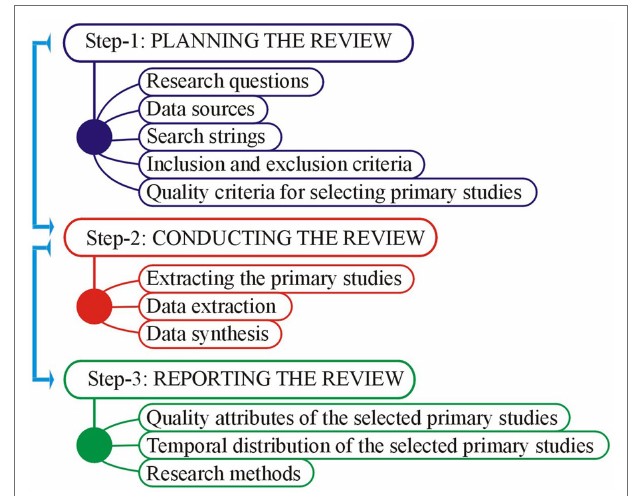
FIGURE 1 | Steps of Systematic Literature